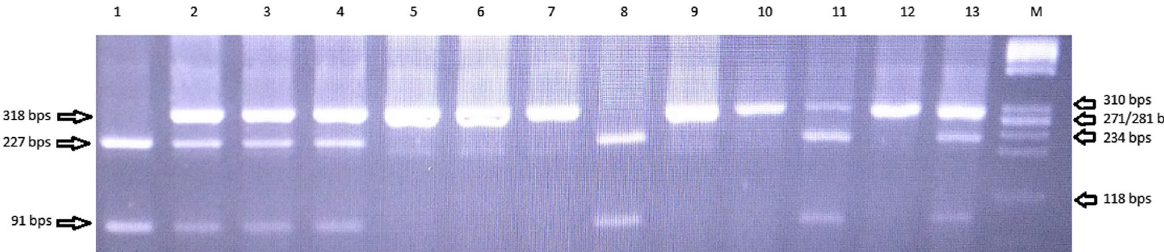
Fig. 1 Digestion patterns of 318 bps amplicon containing C677T site showing (i) normal allele pattern (677CC) with intact 318 bps fragment in cases 5, 6, 7, 9, 10, and 12, (ii) heterozygous mutant allele pattern (C677T) with 318, 227, and 91 bps fragments in cases 2, 3, 4, 11, and 13, (iii) homozygous mutant allele pattern (677TT) with 227 and 91 bps fragments in cases 1 and 8. (M) lane represents ΦX174 DNA/HaeIII Marker